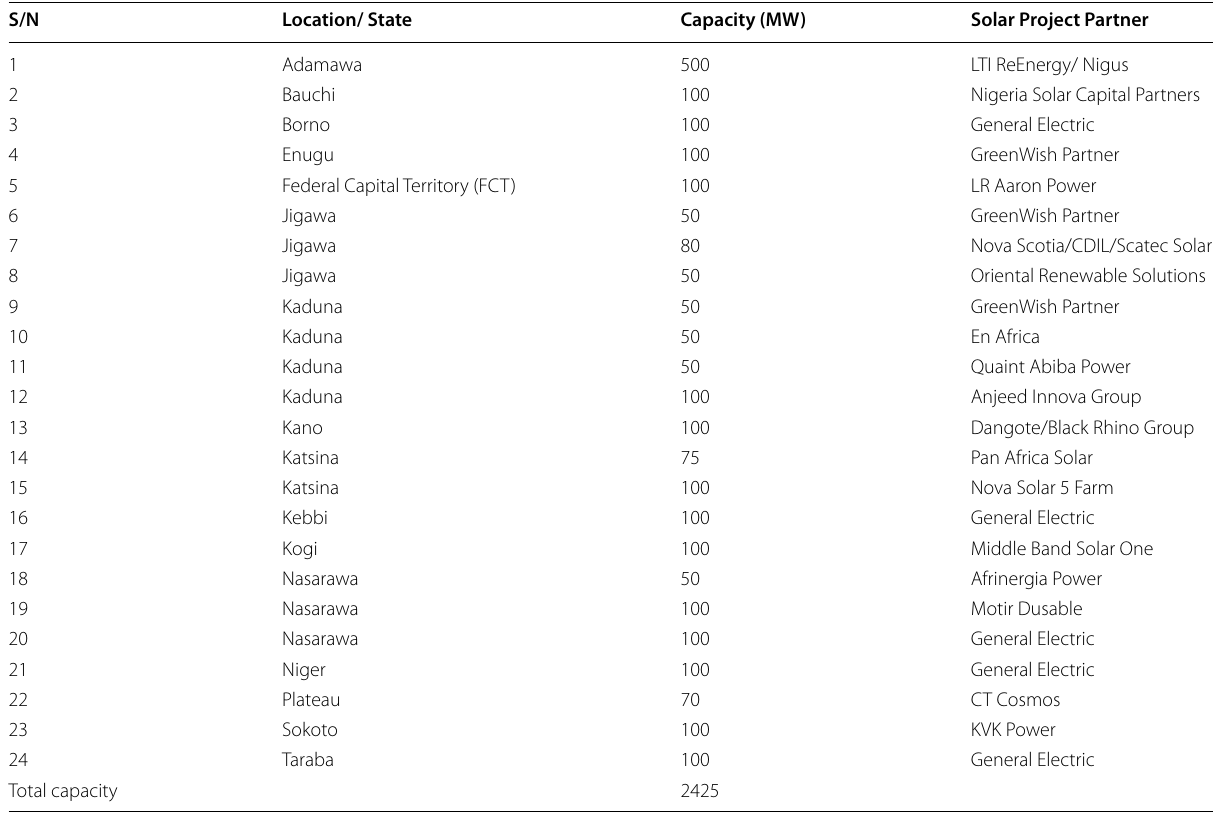
Table 1 Proposed solar power plants based on Nigerian Bulk Electricity Trading Plc signed Power Purchase Agreements (SWE